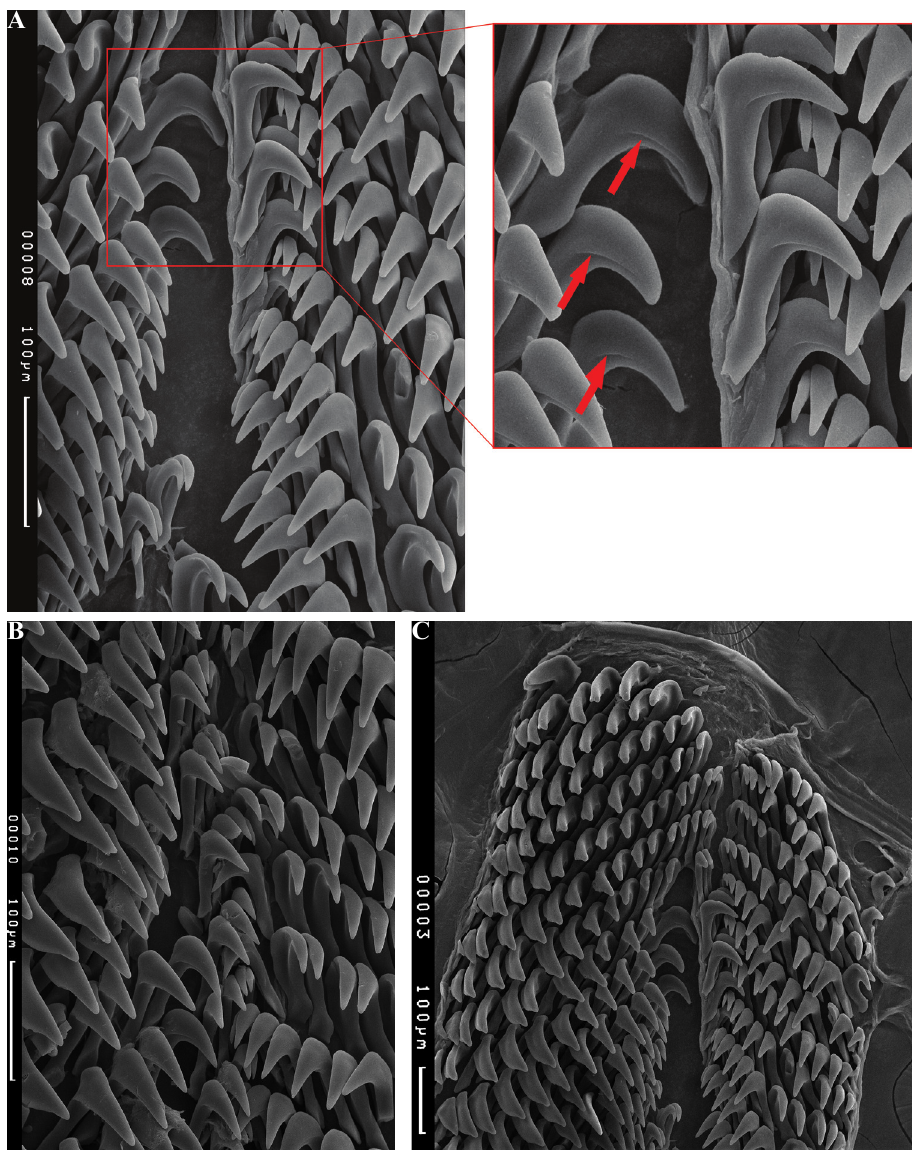
Figure 12. Paradoris hypocrita sp. nov., SEM radular images A middle rows [from Fig. 12C] magnified to show a few of the teeth with the distinctive groove (arrowed); paratype SMF 360588 B newer rows of paratype SMF 360589 specimen B) C old end of radula, paratype SMF